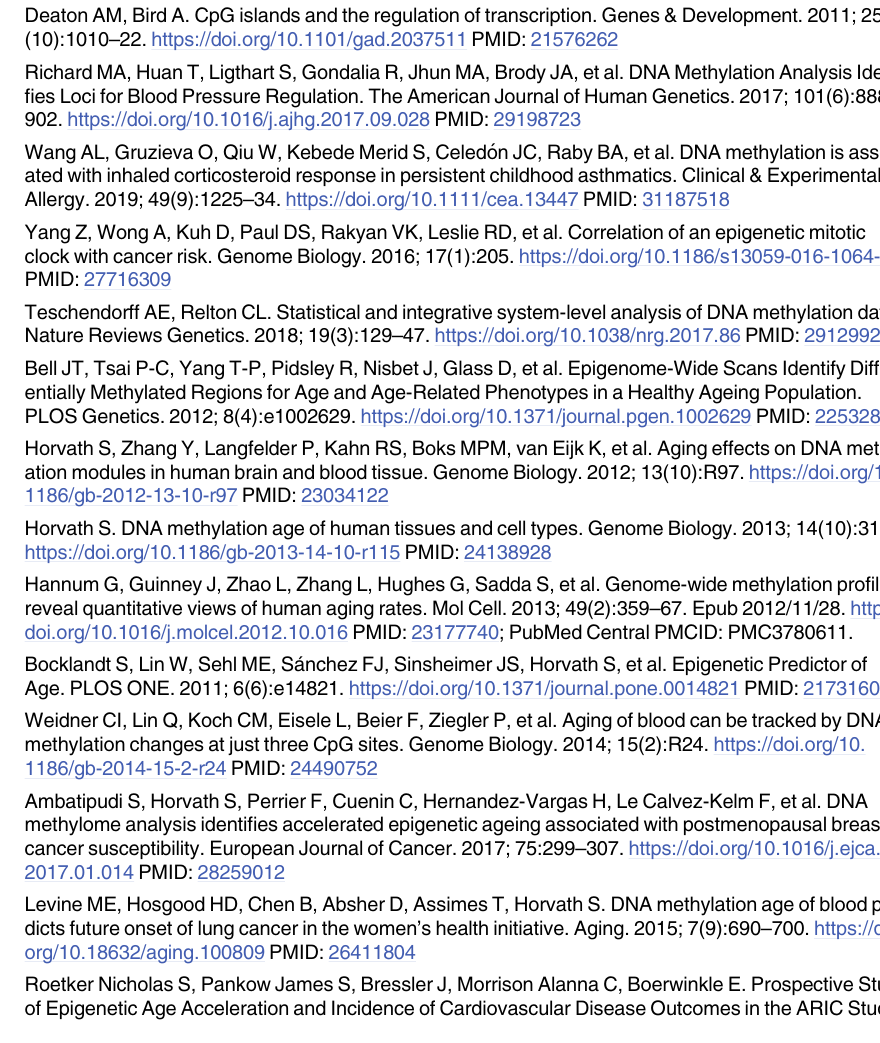
S2 Table. Lifespan age relevant genes selected from the whole blood dataset by the three models. S3 Table. Lifespan age relevant DMRs selected from the 450K brain dataset by the three models. S4 Table. Overlapping between clock model selected gene features and the GenAge data-